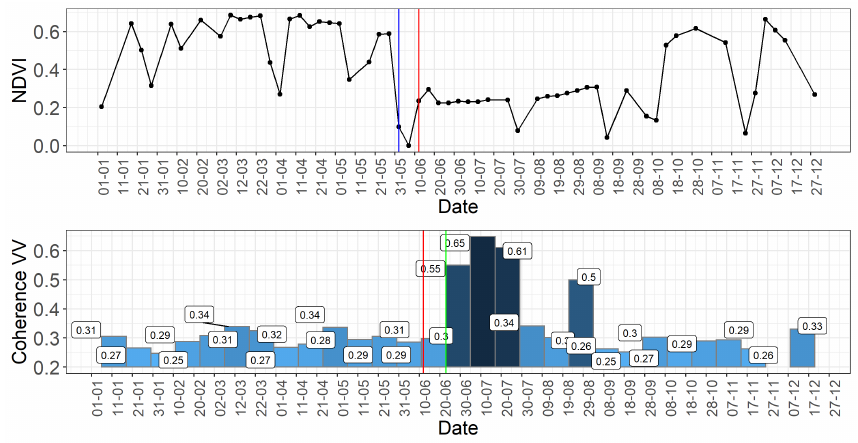
Figure 16. Example of false response of the optical algorithm due to cloudiness in June (cid = 226). Actual harvest date (red lines): 12 June 2018; harvest date according to the optical algorithm (blue lines): 2 June 2018; harvest date according to the SAR algorithm (green line): 23 June 2018.